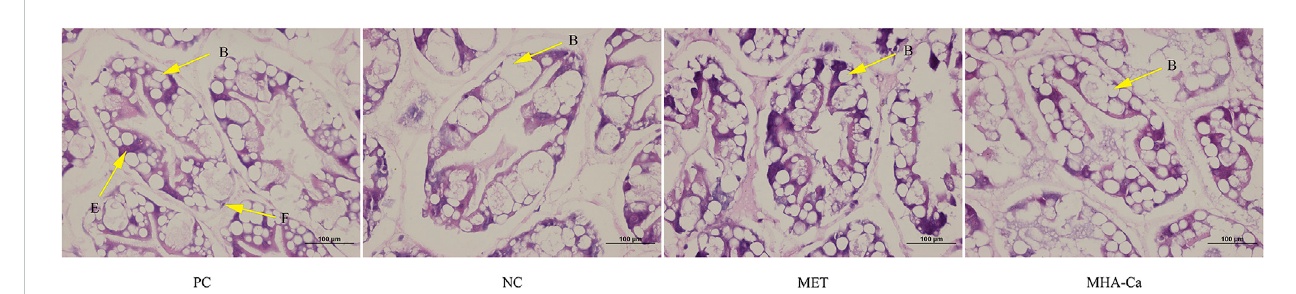
FIGURE 1 Representative histological photomicrographsofhepatopancreas from L.vannamei feddifferentdiets(H&Estaining,magni fi cation×400).ThelettersB, E, F in tubules represent blister cells (B cells), embryonic cells (E cells) and fi brillar cells (F cells), respectively.